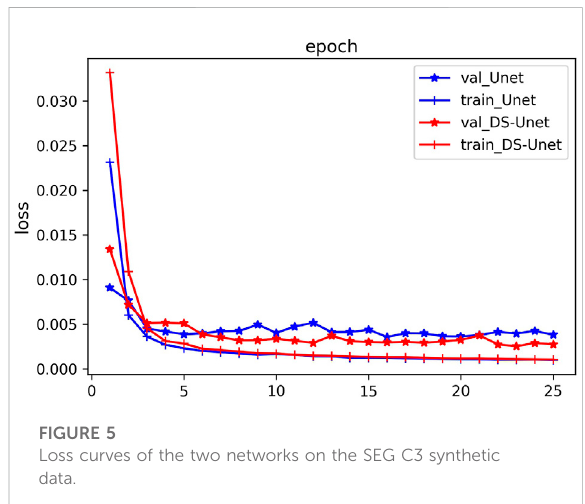
FIGURE 5 Loss curves of the two networks on the SEG C3 synthetic